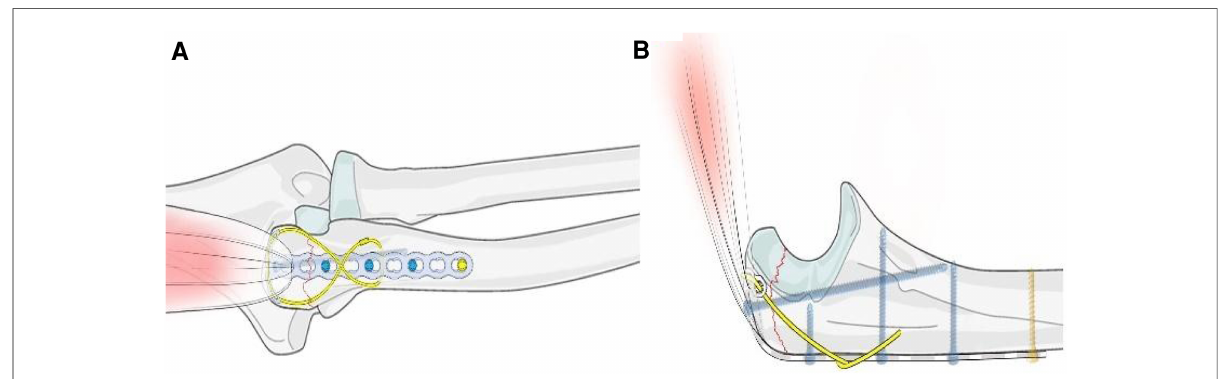
FIGURE 1 Illustration of reduction and fi xation of proximal ulna avulsion fractures and elderly patients with osteoporosis using a T-plate combined with a wire. (( A ) anteroposterior position; ( B ) lateral